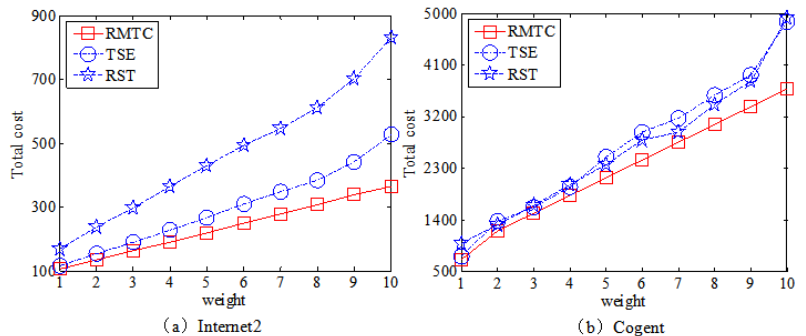
Figure 14. Impact of weight α from 1 to 10 in ( a ) Internet2, ( b )